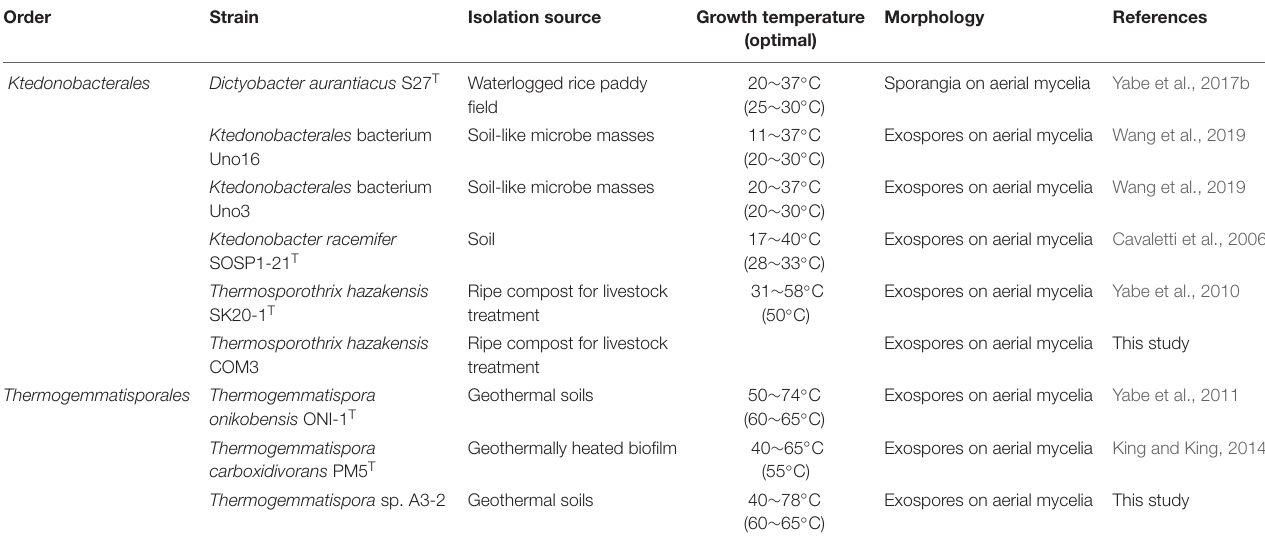
TABLE 1 | Strain information of the nine studied Ktedonobacteria